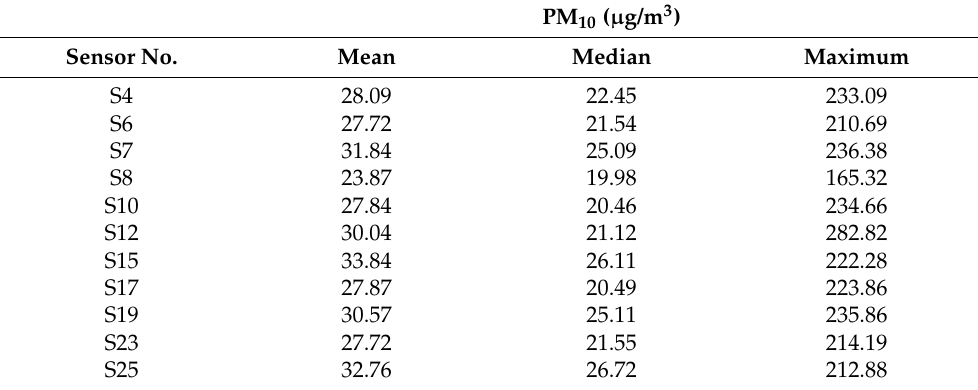
Table 3. Hourly average values of particulate matter recorded over the 1-year monitoring period.